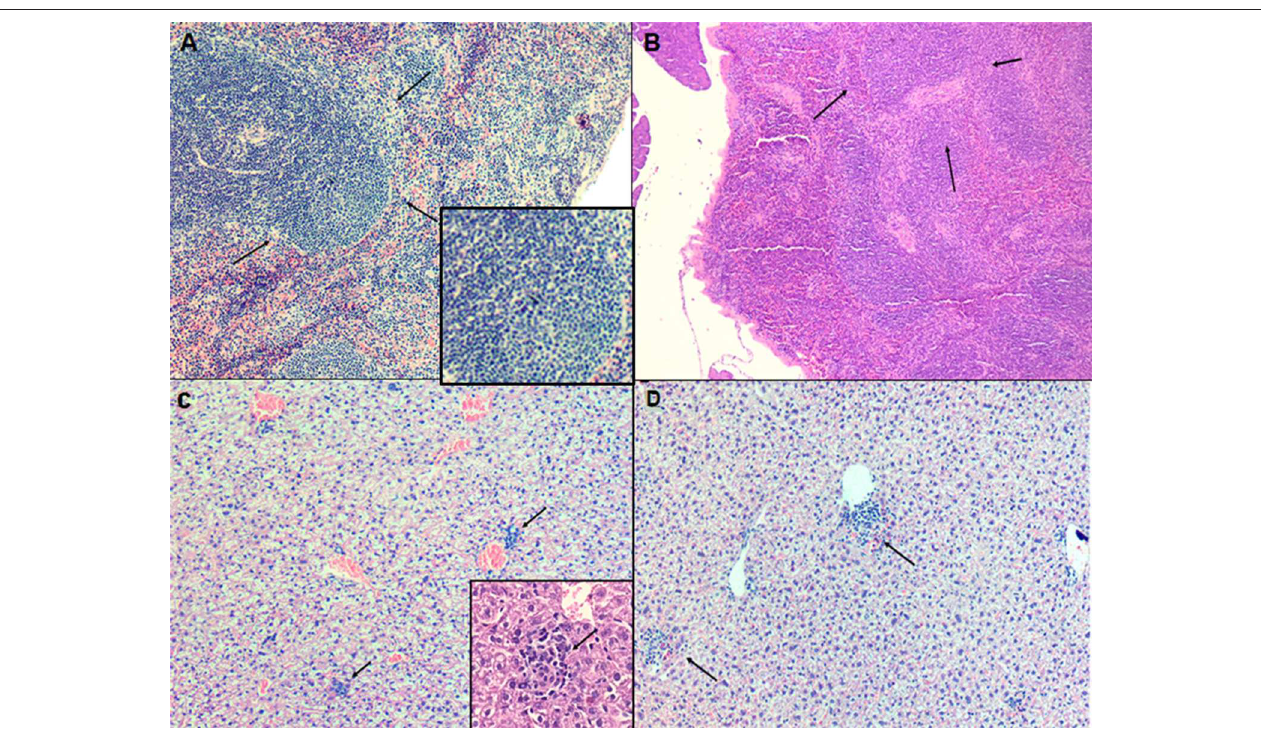
FIGURE 4 | Evaluation of histopathological profile of BALB c mice infected with L. (L.) infantum , after 10 consecutive days of treatment with liposomal sertraline. (A) Spleen of an animal representative of untreated group. (B) Spleen of an animal representative of the group treated with liposomal sertraline at 1 mg/kg. (C) Liver of an animal representative of the untreated control group. (D) Liver of an animal representative of the group treated with liposomal sertraline at 1 mg/kg. Presence of granulomas in all groups (arrows). Staining of H&E, 100 ×